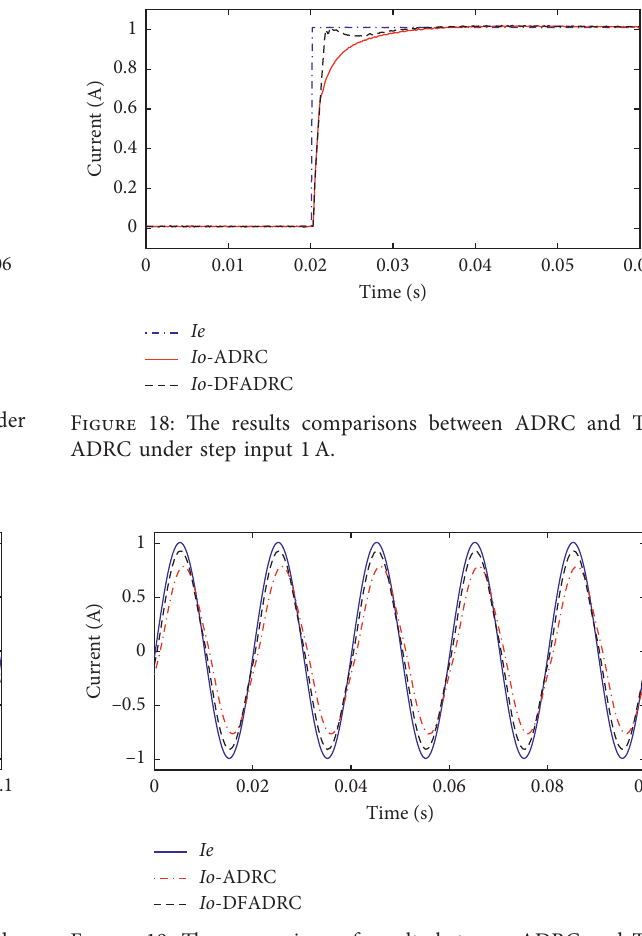
Figure 17: The results comparisons between PI and ADRC under sinusoidal input (1 A, 50Hz).